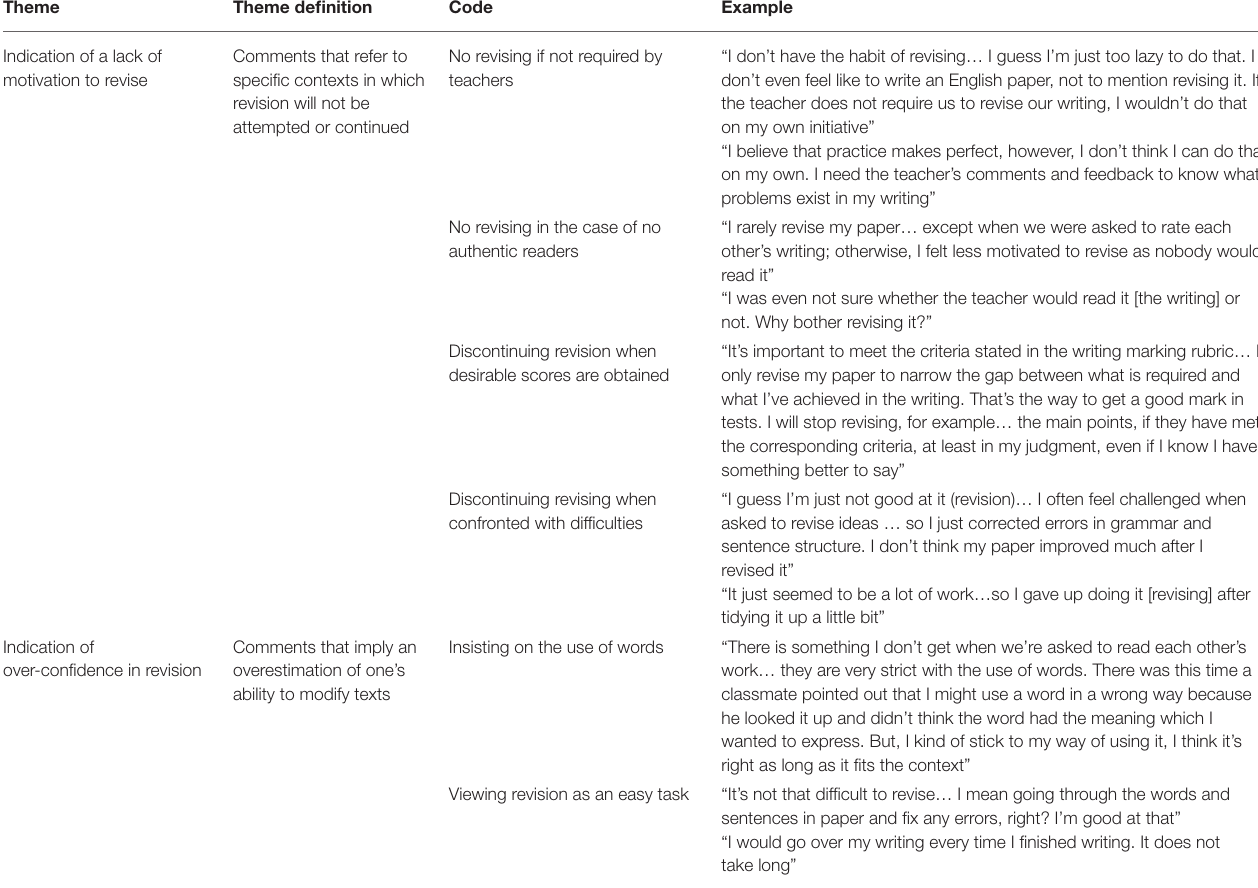
TABLE 3 | Themes and codes identified in pretest